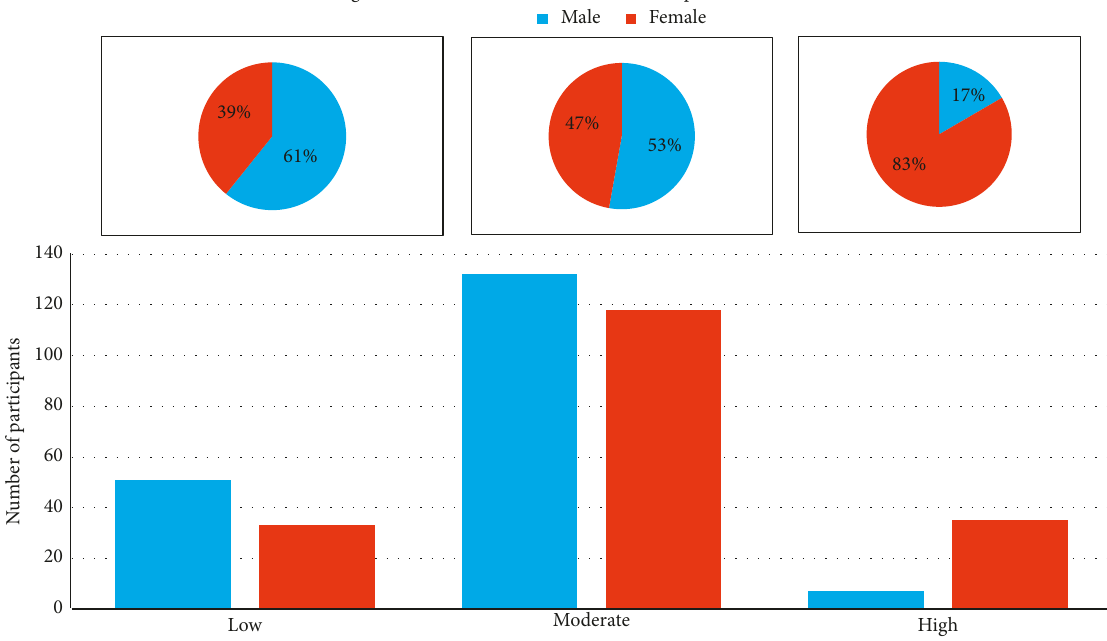
Figure 4: Knowledge levels of females and males about osteoporosis and its risk factors.